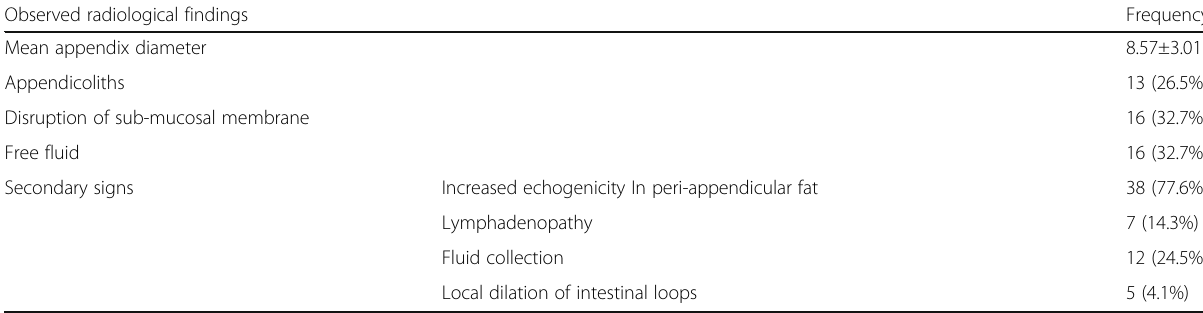
Table 1 Ultrasonography findings in patients with appendicitis Observed radiological findings